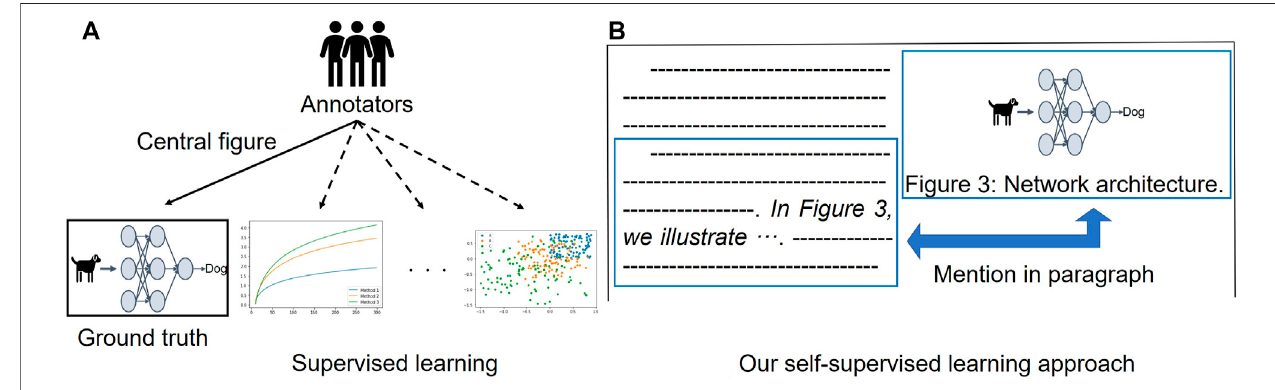
FIGURE 1 | Illustration of our proposed self-supervised learning for central fi gure identi fi cation. (A) Existing supervised learning approach (Yang et al., 2019) requires labeled data for model training. (B) Our proposed self-supervised learning utilizes an inline reference to fi gure, which can be obtained without manual